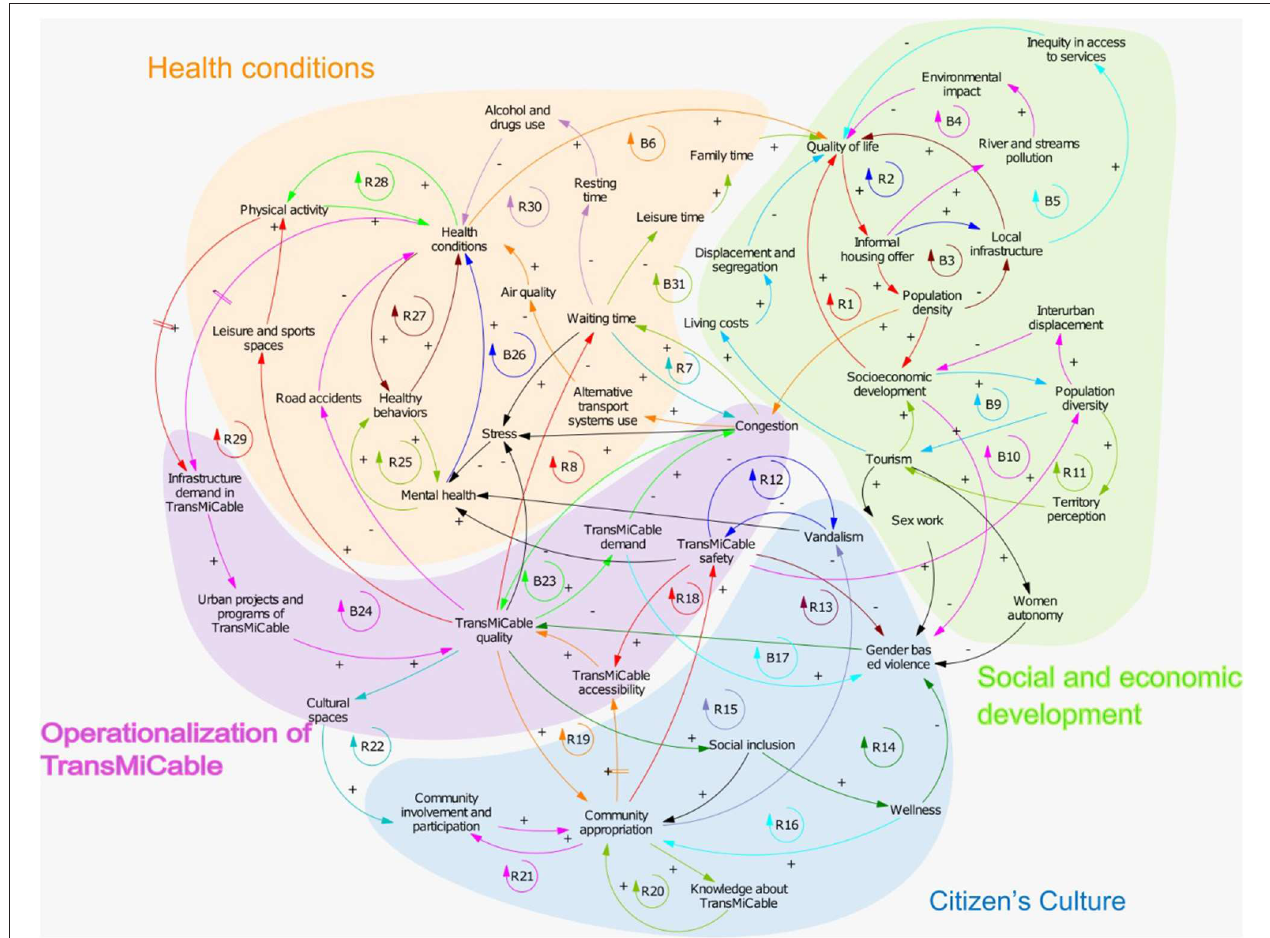
FIGURE 2 | Causal Loop Diagram Depicting the Conceptual Framework of TrUST.